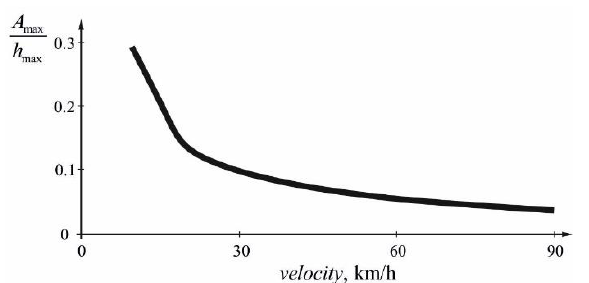
Figure 3. The relative amplitude of vertical vibrations of the body during overcoming single road unevenness with different velocities, where A max —the maximum value of the magnitude of the body vibrations, and h max —maximum height of unevenness .